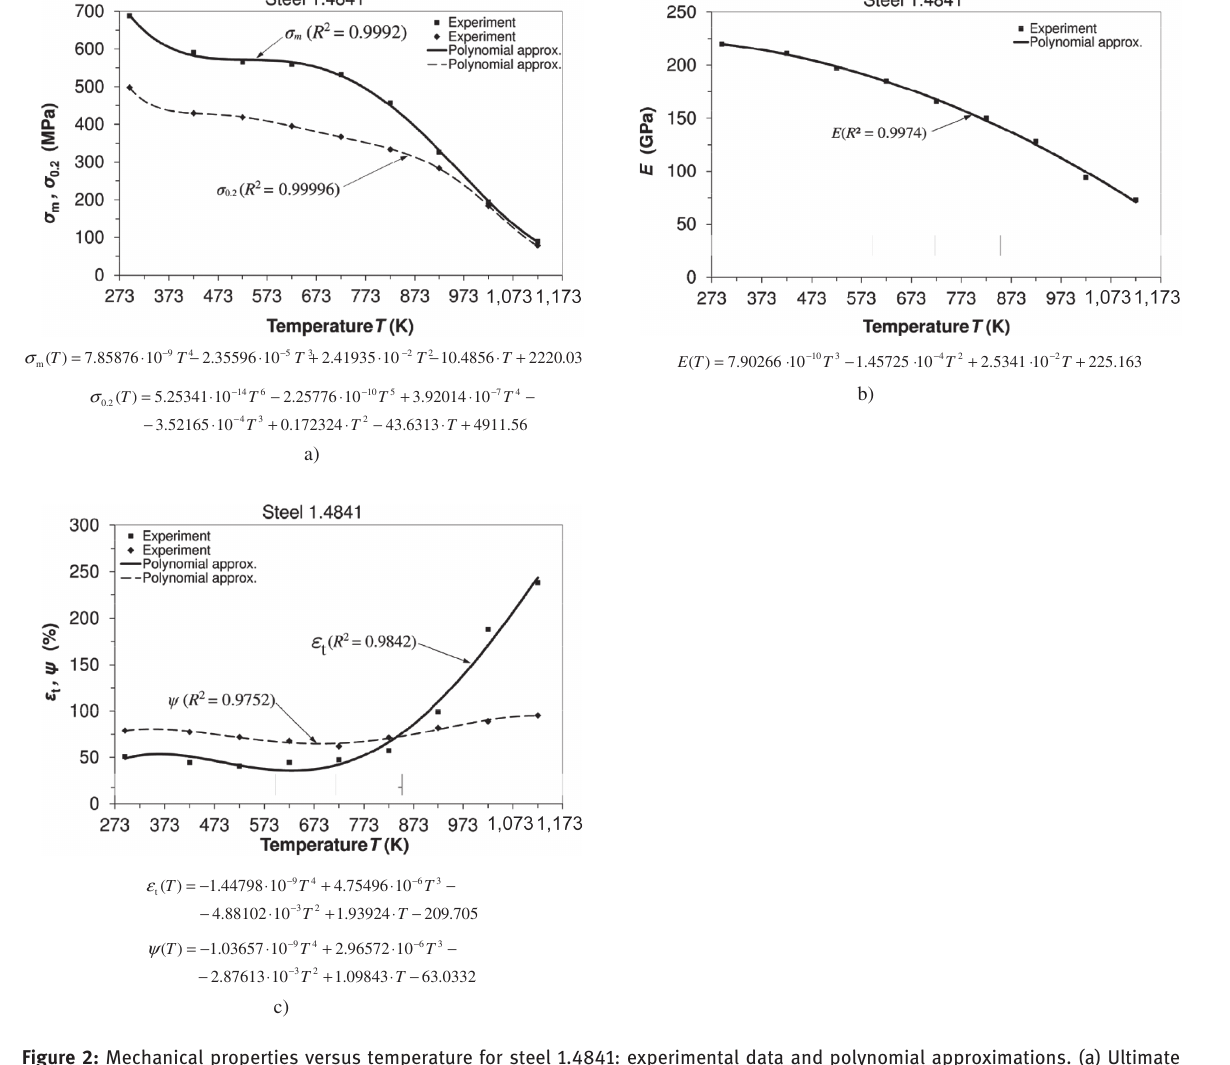
Figure 2: Mechanical properties versus temperature for steel 1.4841: experimental data and polynomial approximations. (a) Ultimate tensile strength ( σ m ) and yield strength ( σ 0.2 ) versus temperature. (b) Modulus of elasticity ( E ) versus temperature. (c) Strain ( ε t ) and reduction in area ( ψ